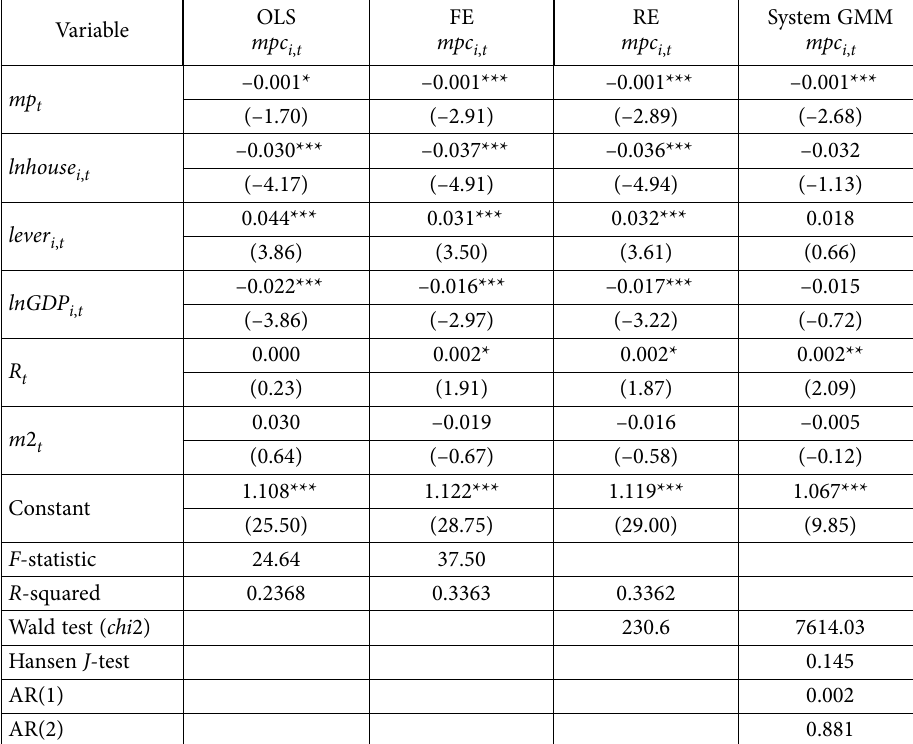
Table 9. The impact of macroprudential policies on consumption through the intersection of the hous- ing market and the credit market